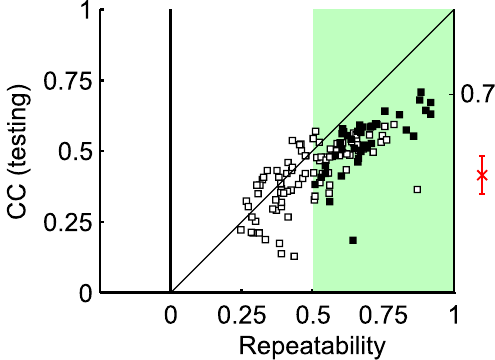
Figure 4. The vertical axis, view-uncontrolled face, and non-face object stimuli (n = 1222) are split into two halves for the two-fold cross-validation test. For each site, the visual feature identified from responses to one half is utilized to predict responses to the other half, and the correlation coefficient between the neural and predicted responses was used as the performance measure. The horizontal axis, the repeatability of each face column estimated by the correlation between even and odd trial-averaged object responses (Spearman- Brown correction). Among 152 face-selective columns (FSI > 1/3, rectangles), we selected 88 reliable sites (repeatability > 0.5) to conduct the cross-validation test. We further identified 39 view-tuned sites (black rectangles) and predicted their view tuning curves (Fig. 2). The red error bar is the performance for predicting activations of a higher DCNN layer (see